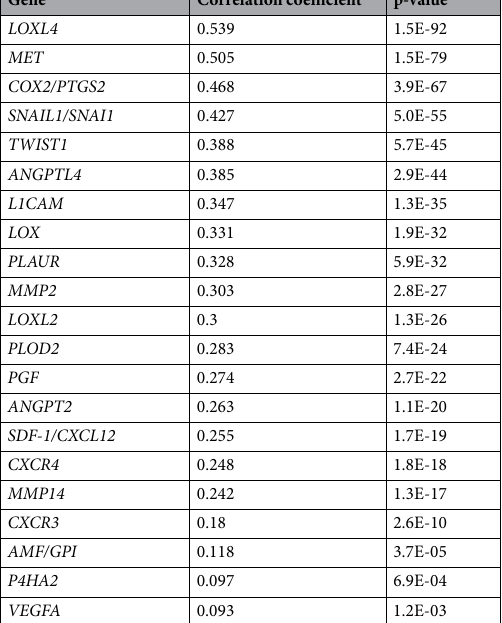
Table 1. Co-expression of CSRP2 with a manually curated set of hypoxia-induced, pro-metastatic, breast cancer genes. A manually formulated set of 26 genes consistently and directly found to be induced by HIF-1 α , as well as being drivers of invasion and/or metastasis of breast cancer cells, was analysed for co-expression with CSRP2 in the large TCGA dataset of gene expression in invasive, human breast cancers (n = 1,215). R values were calculated using Pearson’s correlation or Spearman’s rho for those genes with a normal distribution or otherwise, respectively, and the R value was used to calculate a p-value given the n of the sample